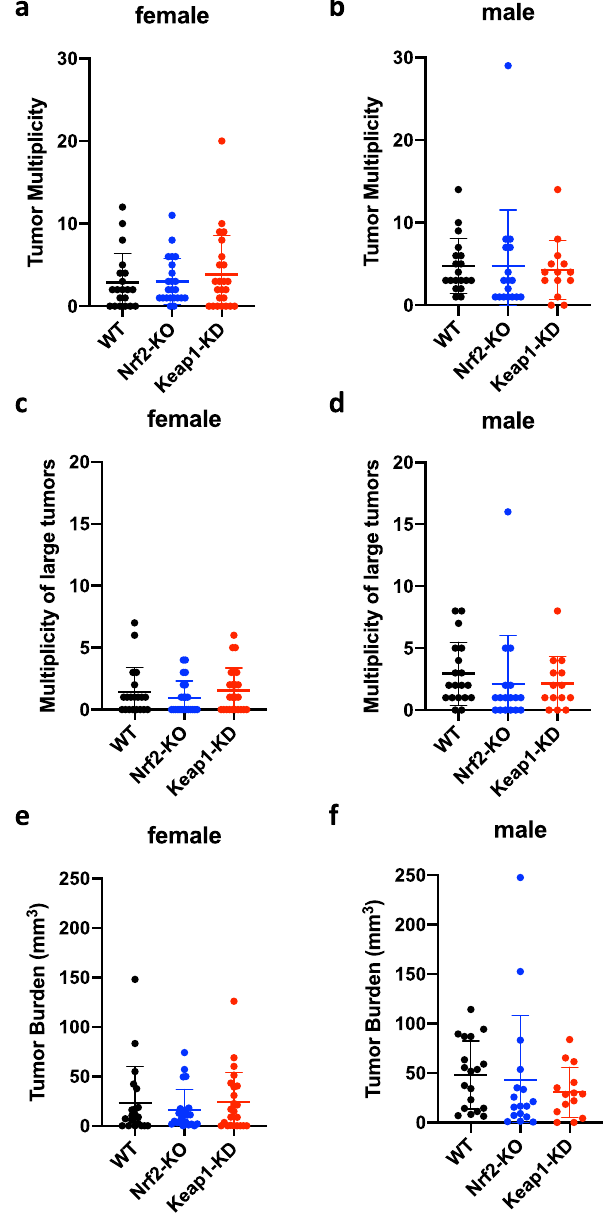
Fig. 2 Genetic activation or disruption of Nrf2 does not affect colorectal adenoma formation in Gstp − / − : Apc Min/ + mice. Tumor multiplicity ( a – d ) and burden ( e , f ) in colons of 20-week-old Gstp − / − : Apc Min/ + : Nrf2 + / + : Keap1 + / + (WT, black circles), Gstp − / − : Apc Min/ + : Nrf2 − / − : Keap1 + / + (Nrf2- KO, blue circles), and Gstp − / − : Apc Min/ + : Nrf2 + / + : Keap1 fl ox/ fl ox (Keap1-KD, red circles) mice ( n = 38 –